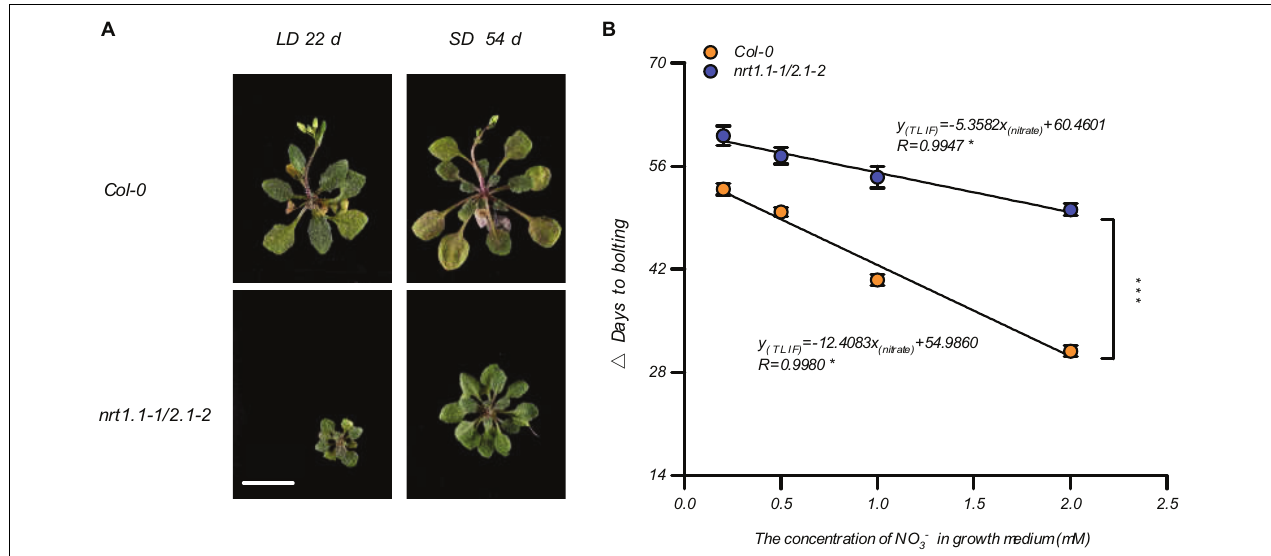
FIGURE 5 | NRT1.1- and NRT2.1-mediated nitrate uptake confers LD-induced flowering. (A) Phenotypic photographs of Col-0 and nrt1.1-1/2.1-2 plants treated with 1.0 mM nitrate. The plants were grown in an agar system containing nitrate as the sole N source, under SD and LD conditions. Scale bar = 1 cm. (B) The time of the LD-induced flowering ( (cid:49) days to bolting) in the Col-0 plants and nrt1.1-1/2.1-2 mutants. Seedlings were grown on agar medium containing a series of KNO 3 concentrations, as indicated. The potassium concentrations in all growth media were adjusted to 2 mM using K 2 SO 4 . SD: 8-h light/16-h dark; LD: 16-h light/8-h dark. (cid:49) Days to bolting was calculated by subtracting the bolting time of the plants grown under LD conditions from that of the plants grown under SD conditions, with the same nitrogen treatment. Raw data from individual photoperiods are shown in Supplementary Figure 10 . At least 20 plants grown in each of the LD and SD conditions were used for the quantification of flowering. Error bars represent ± standard deviations ( n = 12). The regression lines were compared using a UNIANOVA. Significant differences between two regression lines were indicated by an asterisk (*** P <